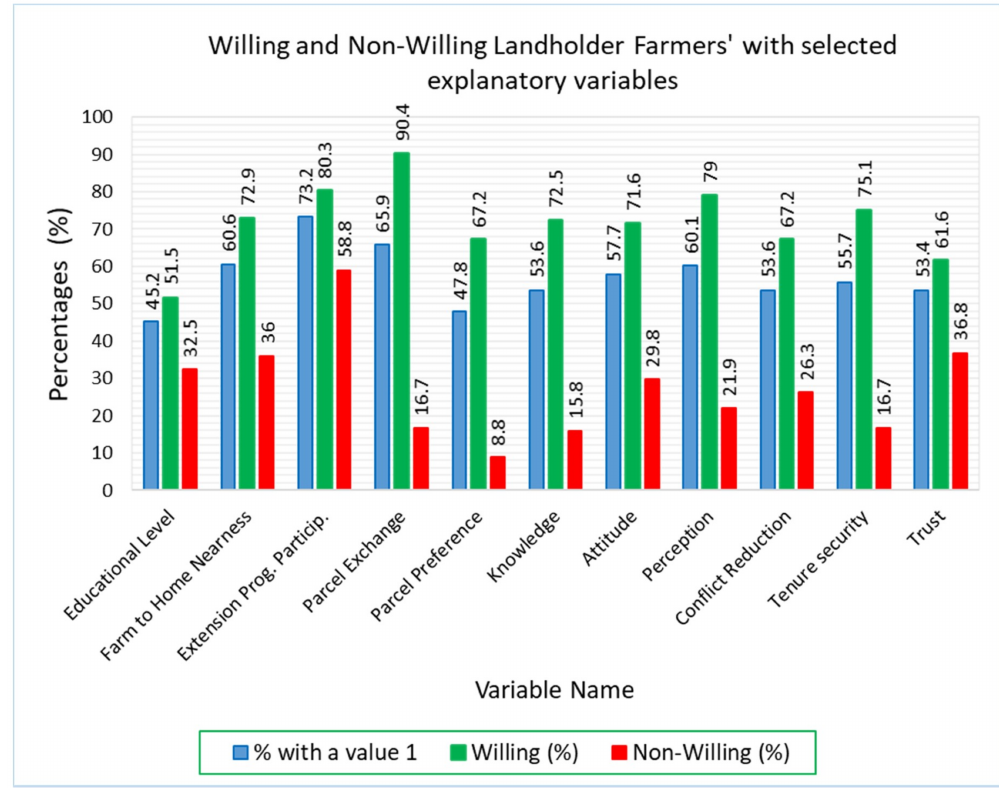
Figure 2. A bar graph showing willing and non-willing landholder farmers with selected explanatory